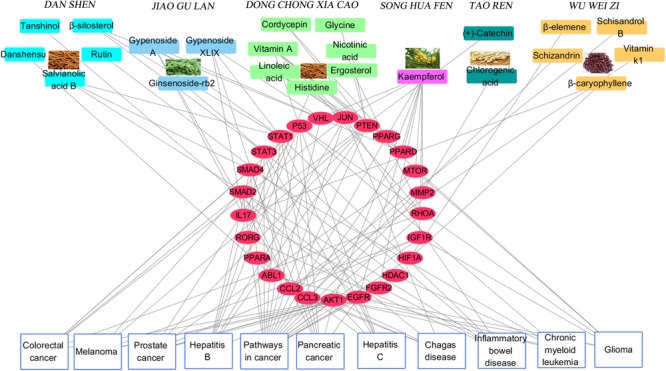
Component-Target protein-Disease network. The Top rectangles in the network represent active components of six herbs in FZHY, red ellipse nodes in the Middle of the network denote target proteins of active compounds, the Bottom rectangles refer to diseases correlated with above target proteins.